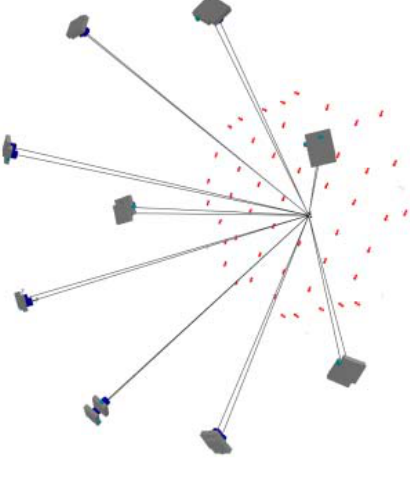
Figure 4. Convergent bundles during camera